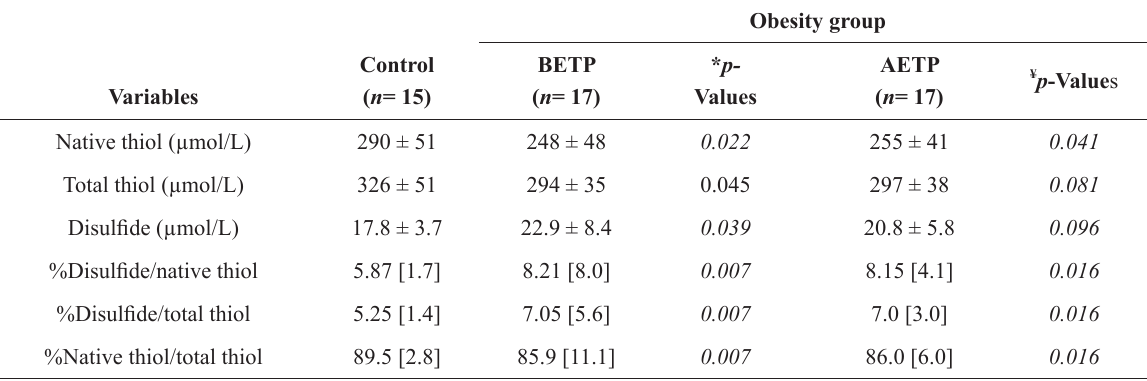
The comparison of TDH parameters between the obese and control groups both prior to and after the completion of the exercise training